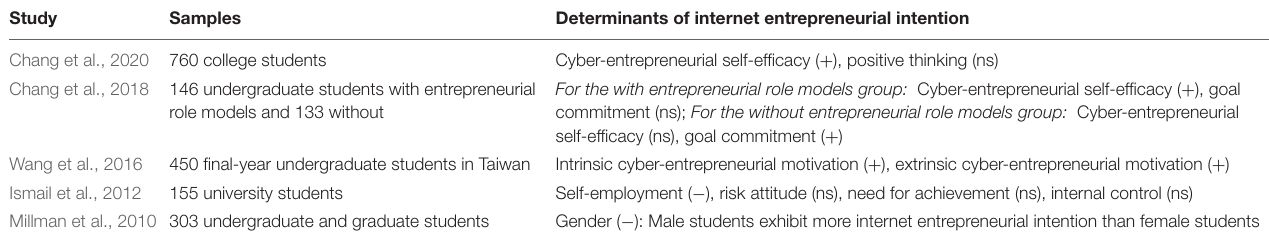
TABLE 1 | Summary of previous research on internet entrepreneurial